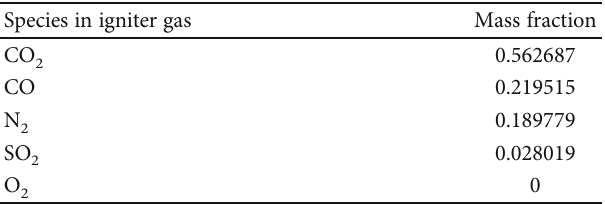
Table 1: Gas species and their fractions.